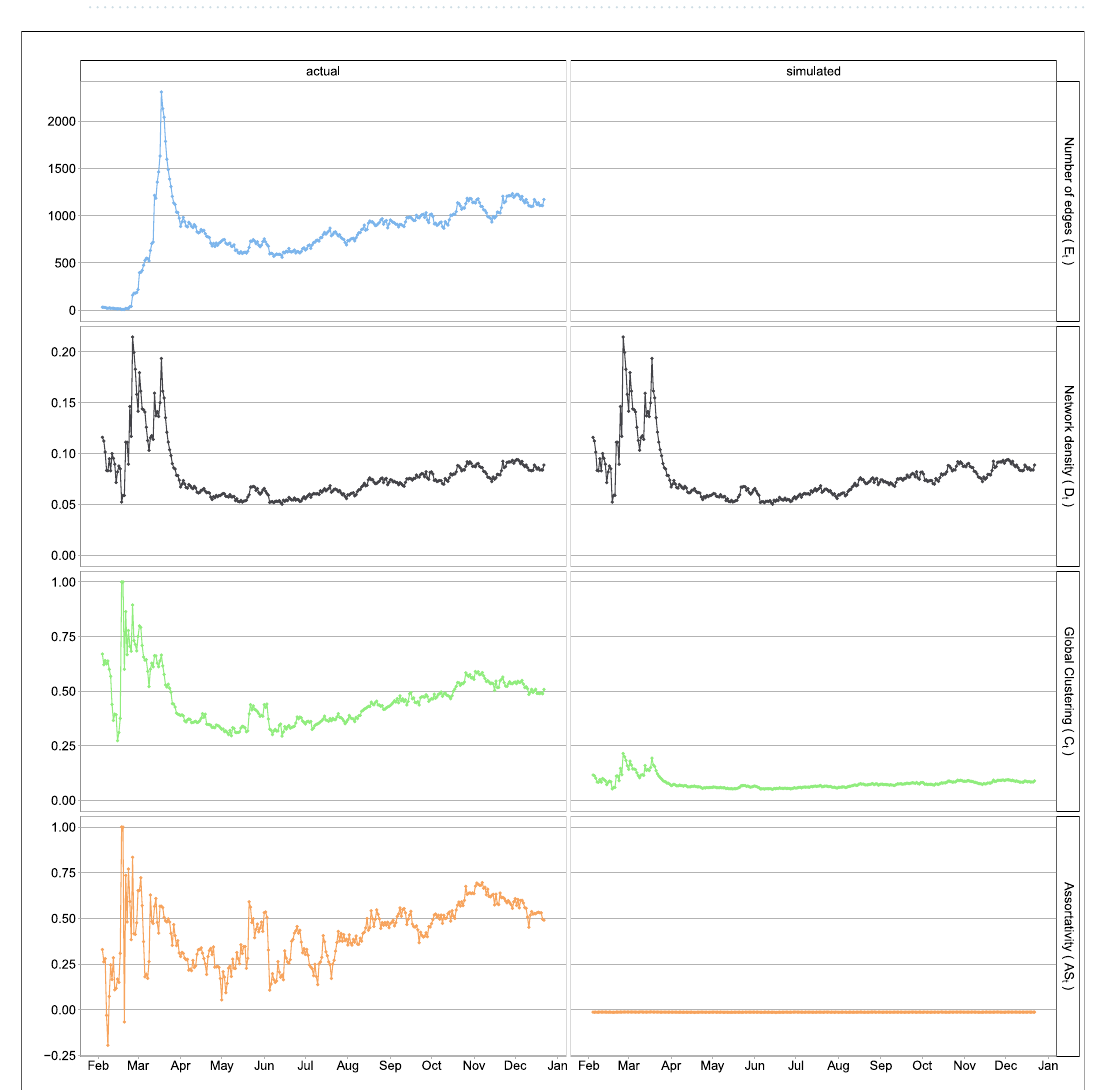
Figure 3. The time series plots of the network statistics, including the number of edges, network density, clustering coefficient and assortativity coefficient. The left column gives the network statistics for the COVID-19 pandemic networks, and the right column gives the corresponding statistics from an independent network, the Erdos–Renyi model (simulated